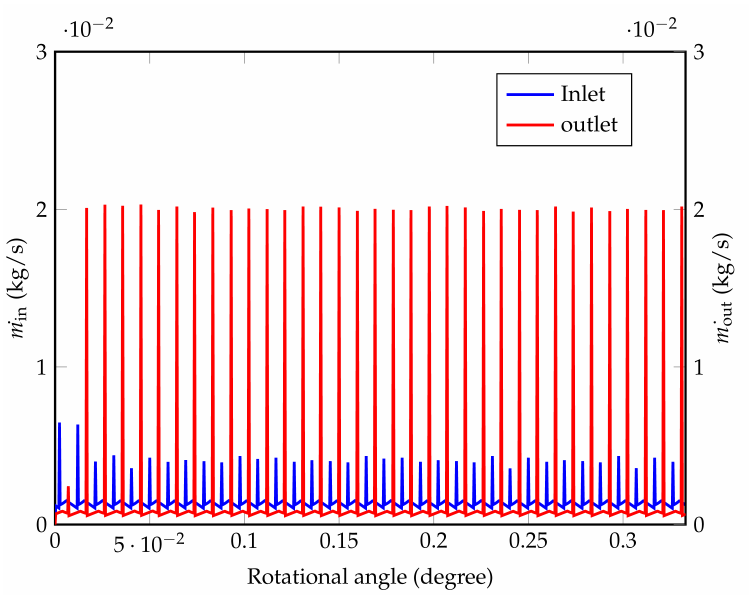
Figure 14. Single cylinder mass and pressure behaviour as a function of the rotational